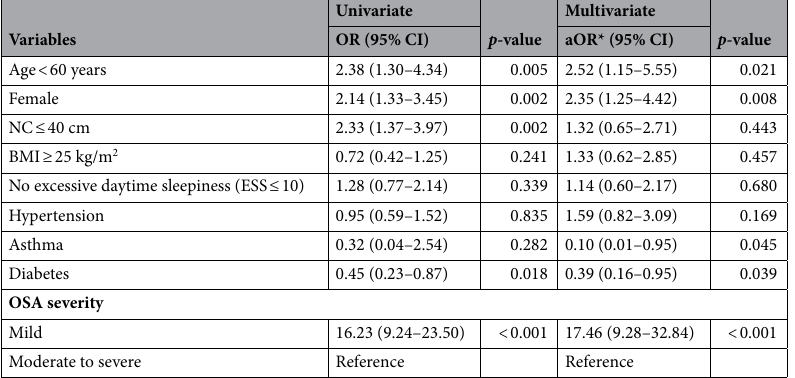
Table 3. Regression analysis of factors associated with REM-related OSA. NC neck circumferences, BMI body mass index, ESS Epworth Sleepiness scale. *Adjusted odds ratio obtained from multivariate logistic regression adjusting for all variables presented in this